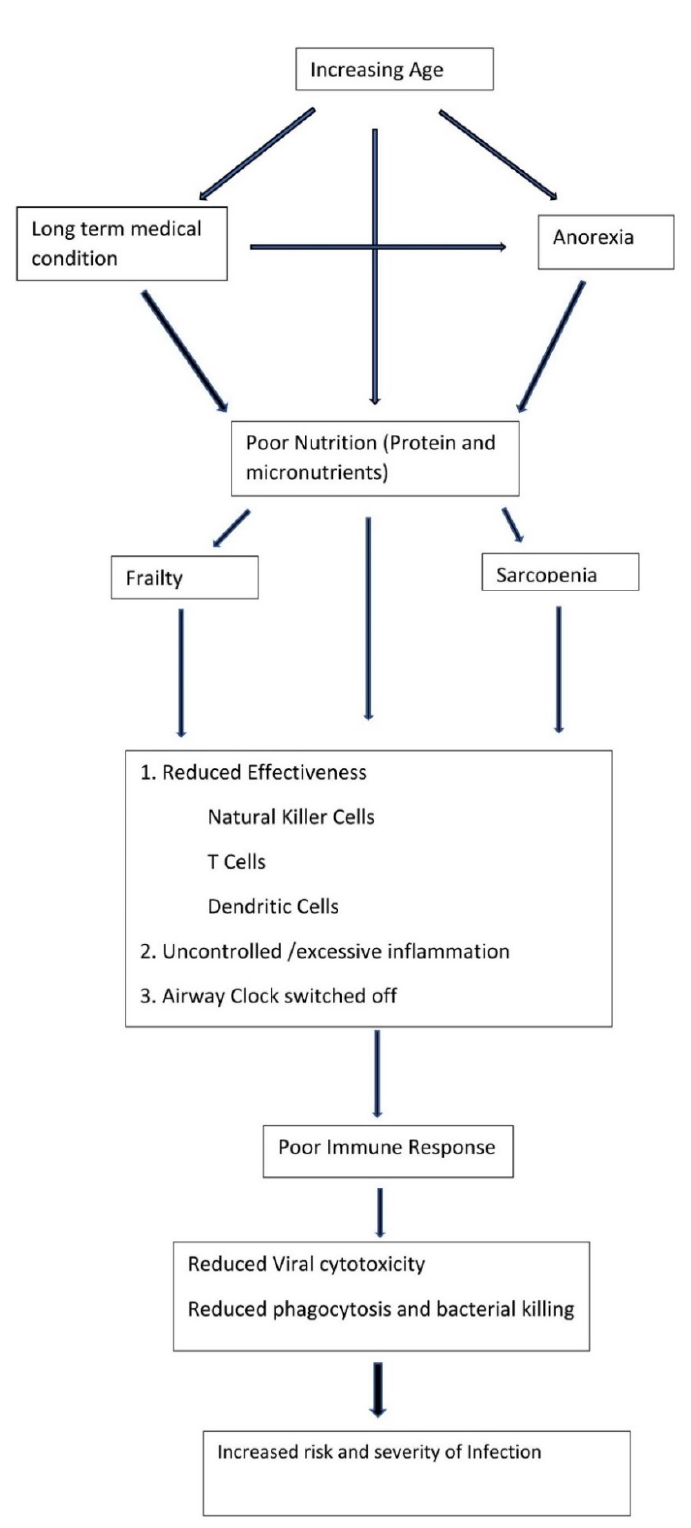
Figure 1. Mechanism of increased infection risk in older frail adults.